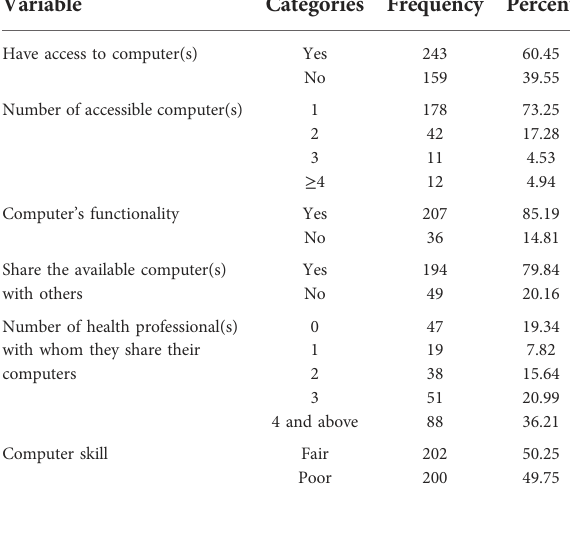
TABLE 1 Socio-demographic characteristics of the study participants, Dire Dawa, Ethiopia, 2019 ( n =402).